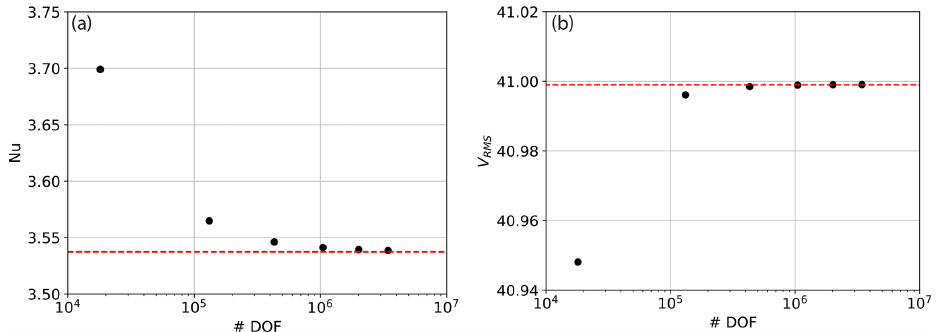
Figure 5. Results from 3-D isoviscous simulations in Firedrake, configured to reproduce benchmark results from Case 1a of Busse et al. (1994): (a) Nusselt number vs. number of pressure and velocity DOFs at Ra = 3 × 10 4 for a series of uniform, structured meshes; (b) rms velocity vs. number of pressure and velocity DOFs. Benchmark values are denoted by dashed red